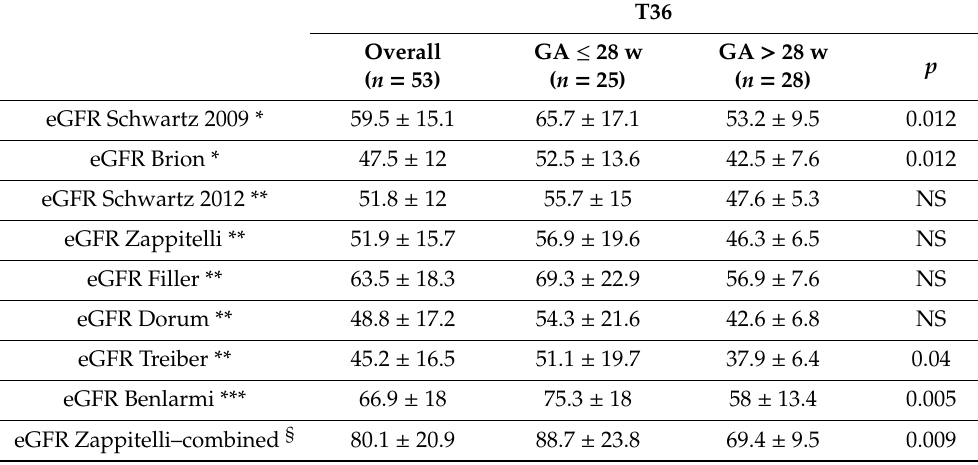
in the overall population and according to GA. All eGFR are expressed in ml / min / 1.73 m 2